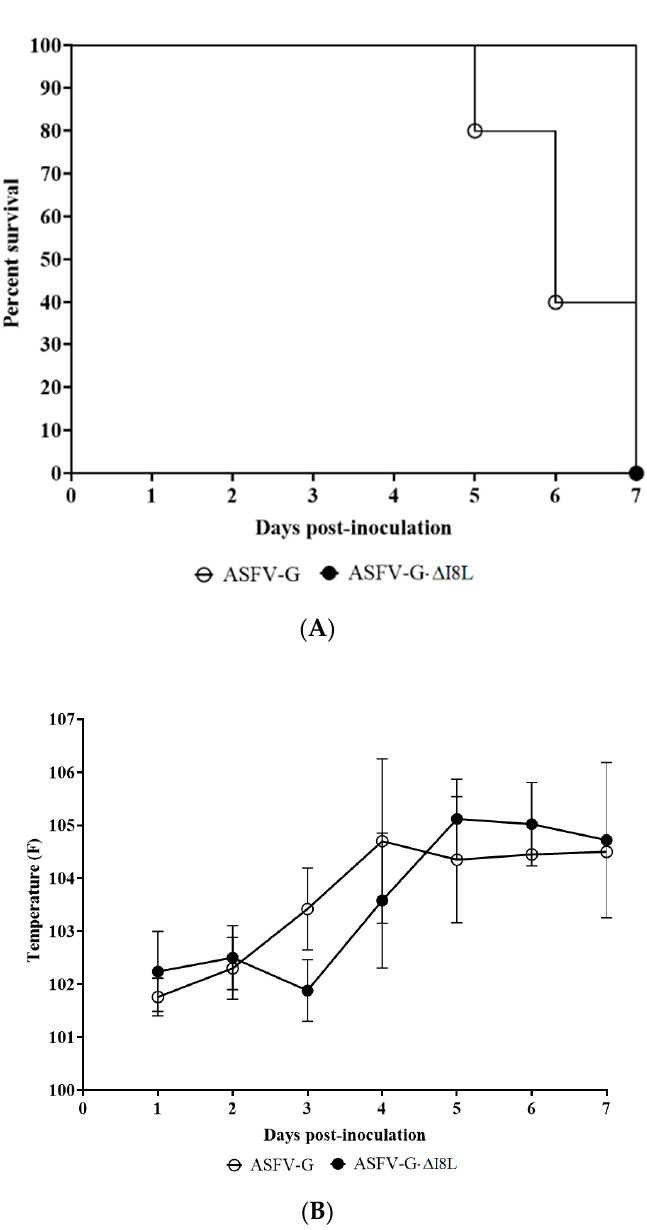
Figure 4. Progress of mortality ( A ) and body temperature ( B ) in animals intramuscularly (IM) infected with 10 2 HAD 50 of either ASFV-G- ∆ I8L (filled symbols), or parental ASFV-G (open symbols). Panel B shows the average data and the corresponding SD.